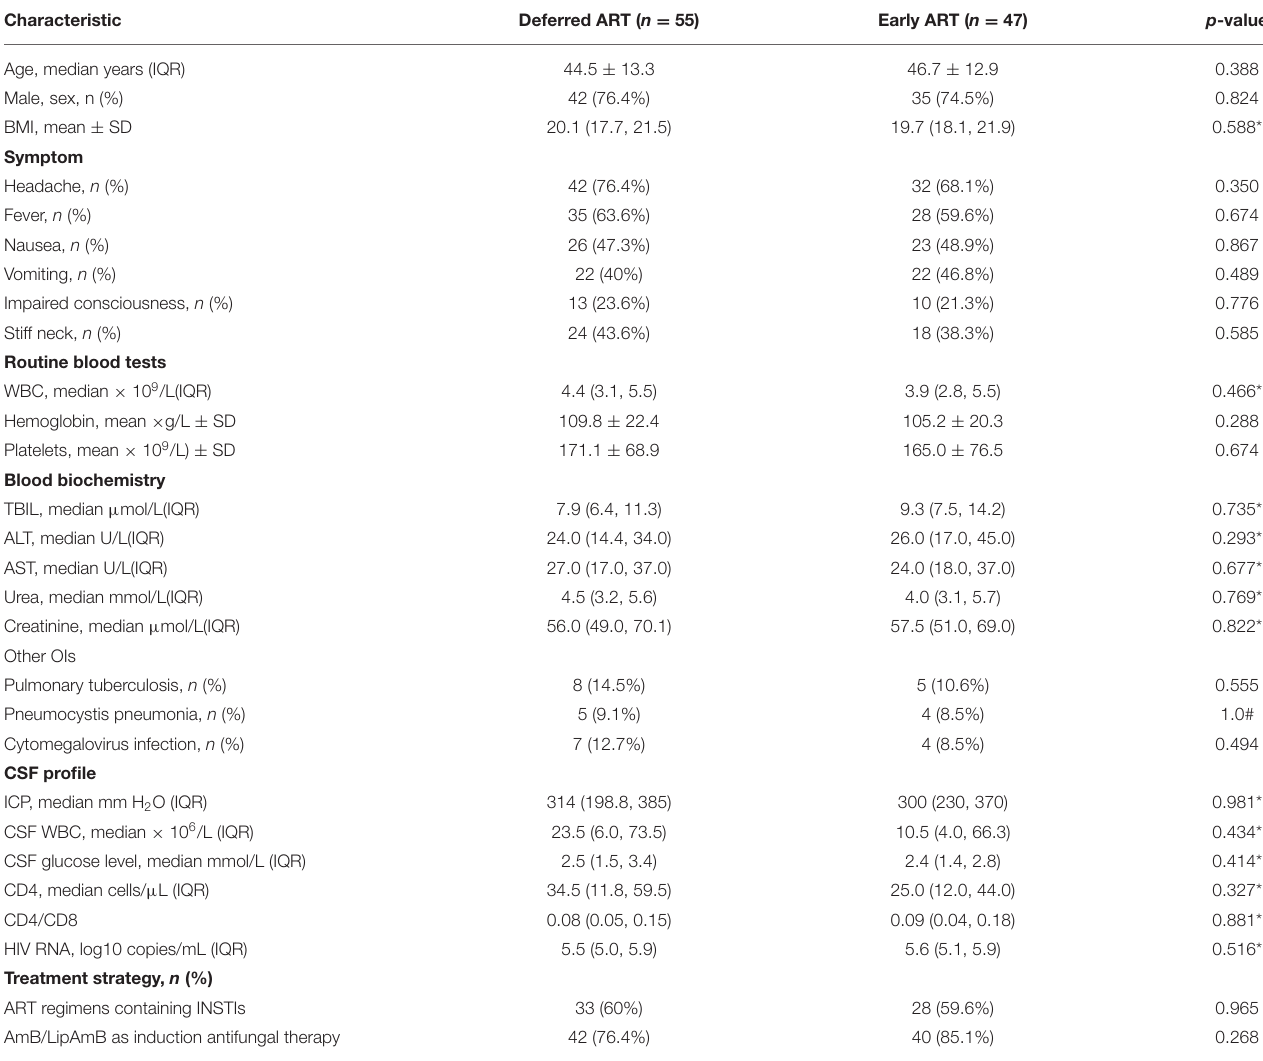
TABLE 1 | Baseline characteristics according to treatment group.